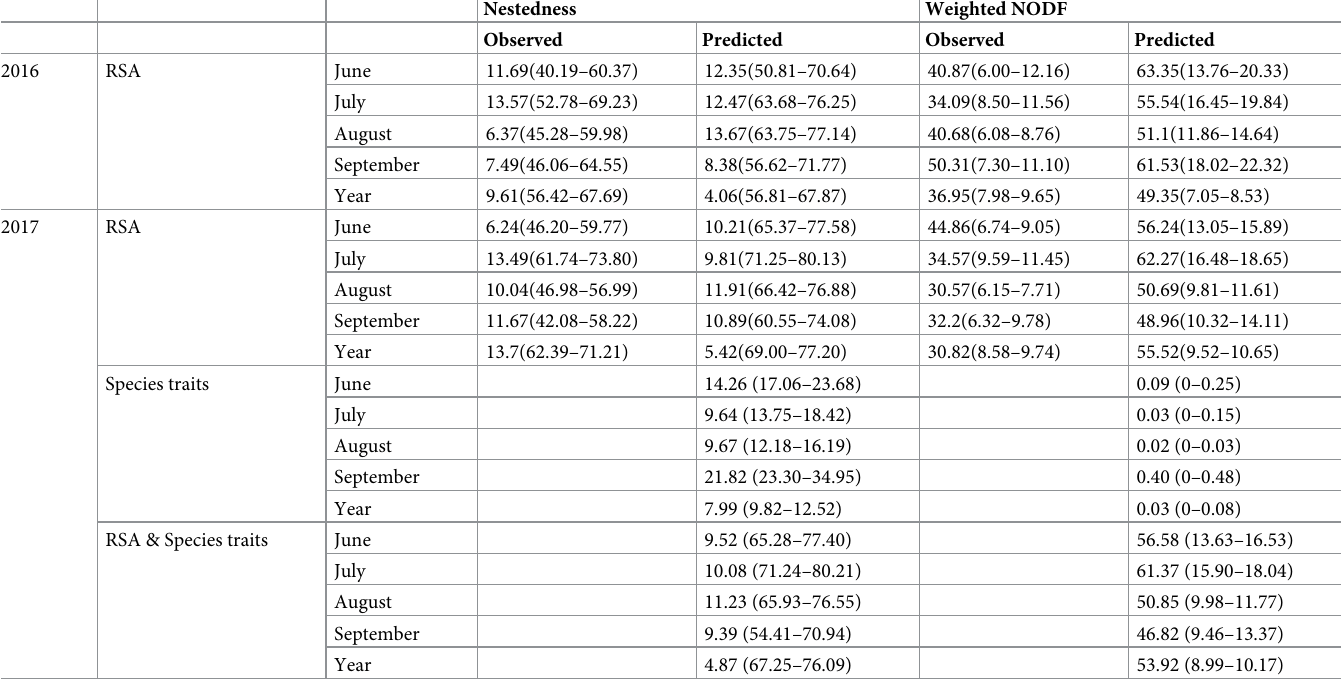
Comparisons of observed vs. predicted indicate that relative species abundance is a good indicator for network nestedness. The value ranges within the parentheses are the 95% confidence intervals of null modes based on the observed and predicted